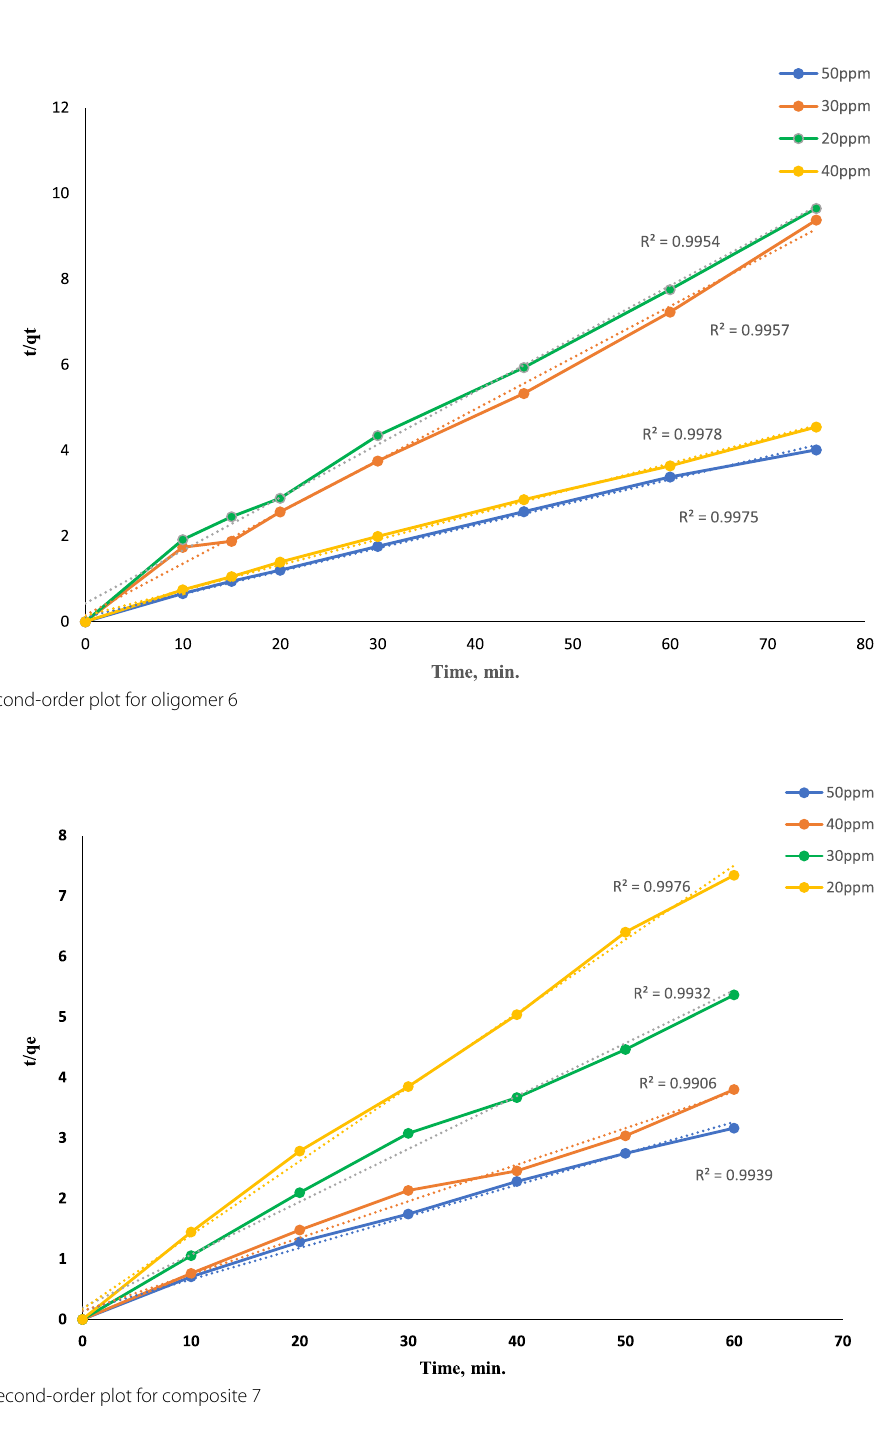
The Freundlich isotherm [42] describes the adsorption equation for nonideal adsorp- tion that involves heterogeneous adsorption and multi- layer coverage of safranin dye onto 3 and 7 surfaces. This empirical isotherm is expressed by eq. (4):